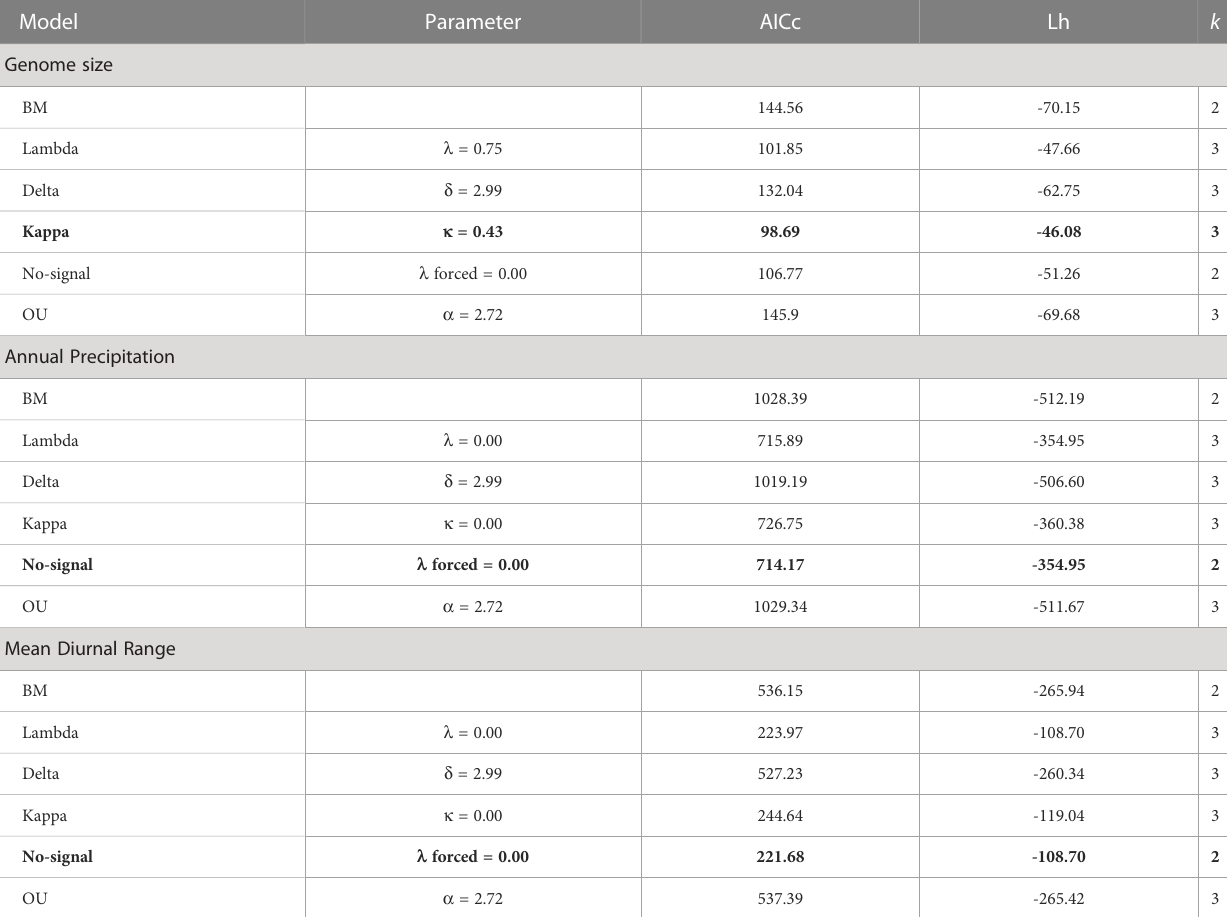
TABLE 2 Selection for the best evolutionary model of genome size and environmental factors in the genus Eragrostis .